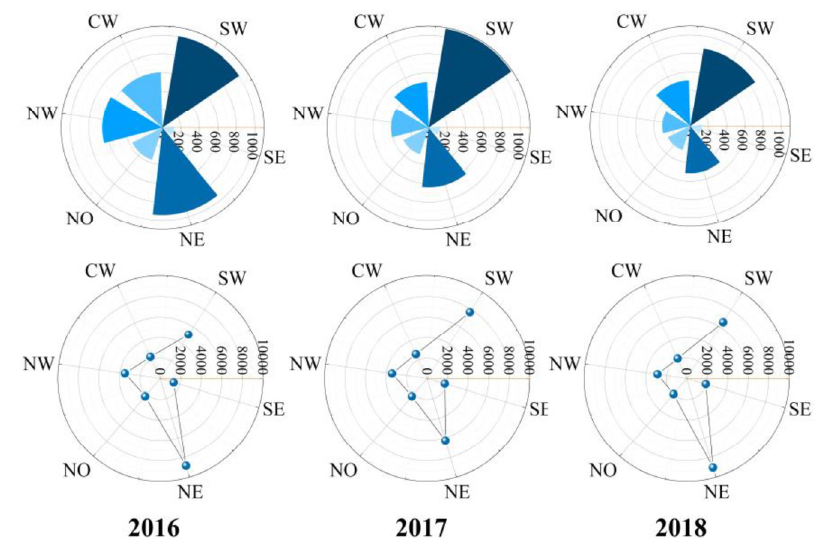
Figure 8. Total area and number distribution of SGLs in each basin. Table 3. Area and number change rate of SGLs from 2016 to 2018 (“A” means area; “N” means number).